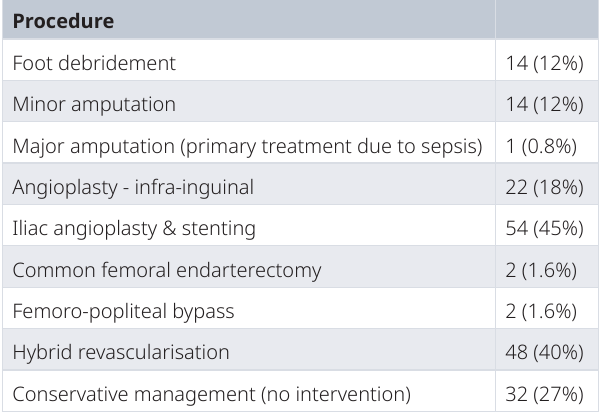
Table 2. Procedures patients underwent after their index secondary care appointment (at outpatients or inpatient admission) and participation in the study; all procedures performed within 2 weeks of consenting to take part (as part of the patients’ care plan).